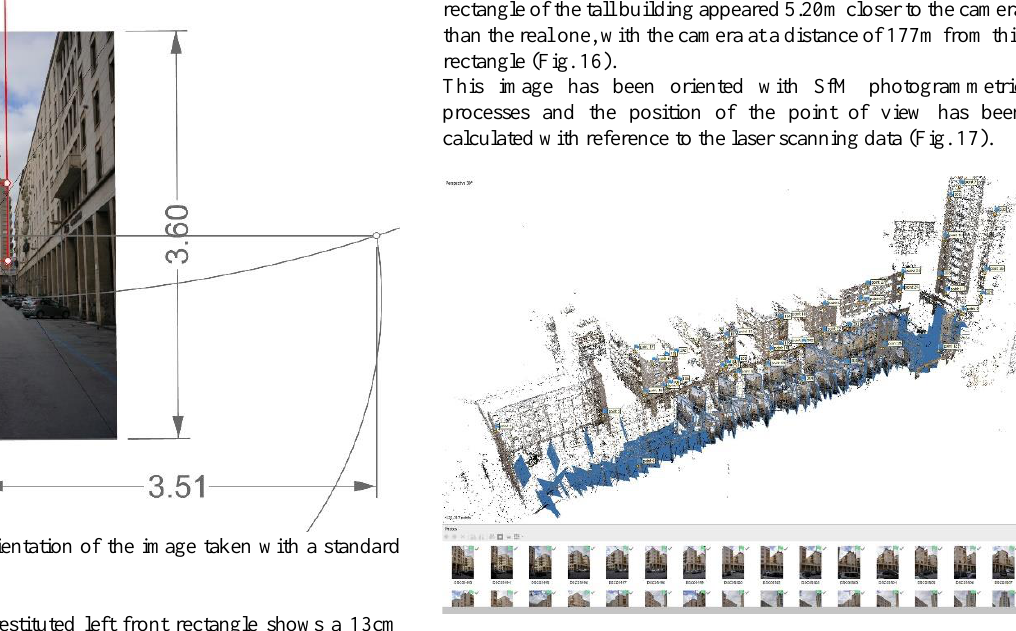
Figure 17: SfM photogrammetric model of the case